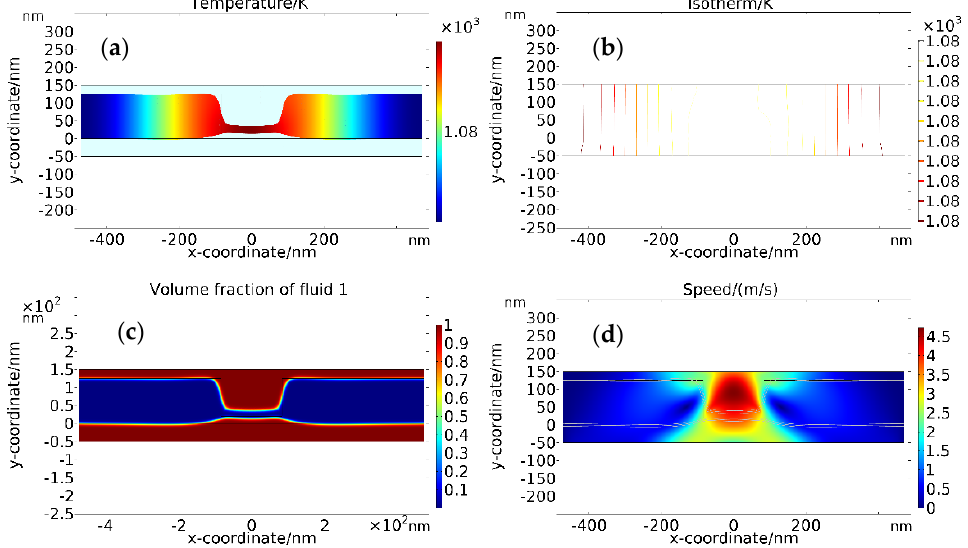
Figure 8. The damaged ridges of ACGs with single-pulsed nanosecond laser irradiation at 0.95 J/cm 2 : ( a ) Temperature field distribution, ( b ) Isotherm map, ( c ) Volume fraction, ( d ) Velocity field.